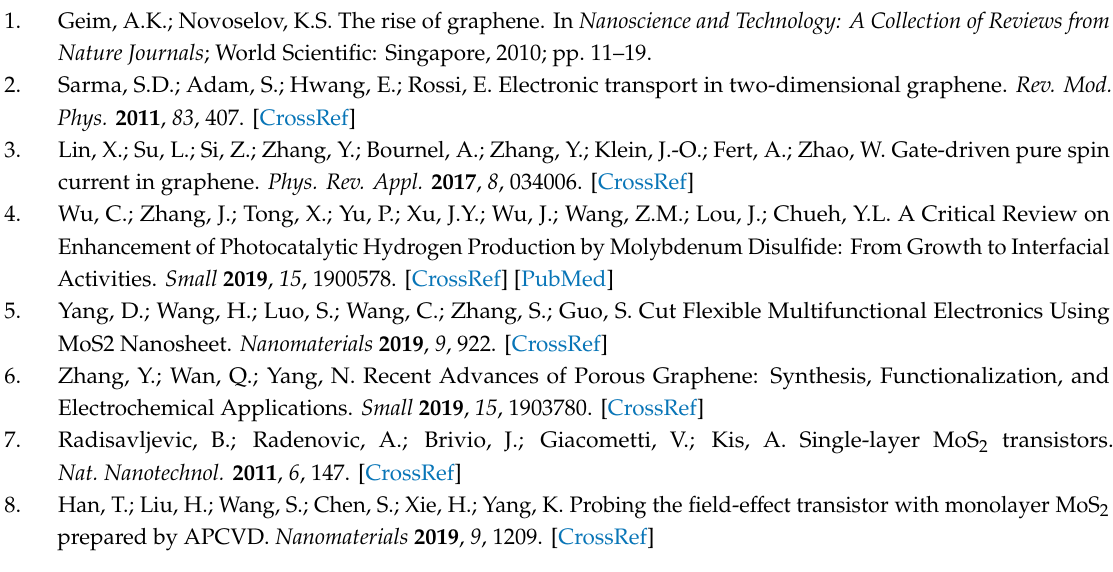
single layer in DNN and 1D-CNN. The result of misclassification of impurity classification; Figure S8: OM image and prediction results of the new pending data at 40 × magnification; Figure S9: At 100 × magnification, (a) and (e) are the OM images of the training (train data) and new test (new pending data) sets. (b) DNN, (c) 1D-CNN, and (d) 3D-CNN indicate the prediction results of the color classification image (false-color composite) in the training data. (f) DNN, (g) 1D-CNN, and (h) 3D-CNN reflect the prediction results of the color classification image (false-color composite) in the new pending data, from DNN and 1D-CNN in the single layer with the wrong double-layer classification misjudgment results; Figure S10: OM image and prediction results of the new pending data at 100 × magnification; Figure S11: At 40 × magnification, the accuracy (Accuracy) and loss (Loss) of the convergence process in (a) DNN, (b) 1D-CNN, and (c) 3D-CNN; validation set in (d) DNN, (e) 1D-CNN, and (f) 3D-CNN confusion matrix results; Figure S12: At 100 × magnification, the accuracy (Accuracy) and loss (Loss) of the convergence process in (a) DNN, (b) 1D-CNN, and (c) 3D-CNN; validation set in (d) DNN, (e) 1D-CNN, and (f) 3D-CNN confusion matrix results; Figure S13: Optical microscope light intensity distribution analysis. (a,d,g) OM images of sapphire substrate taken at 10 × , 40 × , and 100 × magnification rates (50, 15, and 10 µ m in the lower right corner, respectively). (b,e,h) V channels in the HSV color space of the microscope image (lightness) light intensity distribution. (c,f,i) Scatter plots of each pixel point RGB channel in the OM image; Figure S14: Prediction rate of each classification type at the shooting magnification rates of (a) 10 × , (b) 40 × , and (c) 100 × ; Figure S15: Raman measurement of the hyperspectral image of the new test data (new data). (a) OM image at 100 × magnification, (b) prediction result compared with OM image at 100 × magnification, (c) Raman spectrum at three specific points in (d), and (d) Raman measurement result corresponding to (b). The number of layers in the ROI circle is consistent, the triangle is a single-layer structure, and the intermediate core point is a double layer; Figure S16: SEM measurement of the hyperspectral image of the new test data (new data). (a,b) are OM images at 100 × and 40 × magnification rates, (c,d) are prediction results corresponding to the (a,b) OM image ranges, and (e,f) correspond to (c,d) ROI measurement results; Figure S17: (a) Photoluminescence spectrometry. (b) OM image of selected PL mapping range. (c) PL mapping with a wavelength of 625 nm (d) PL mapping with a wavelength of 667 nm. (e) The blue measurement in (d) indicates the PL measurement result of the test piece; Figure S18: (a) is the OM image after growing MoS 2 , (b) is the cross-sectional TEM image of the selected area of (a), (c) is the magnified TEM image of the red arrow of (b). (d) is the HRTEM image at the red box in (c). (e) is the HRTEM image at the orange box in (c), and (f) is the HRTEM image at the yellow box in (c). (g) is the SAED diagram of (d), (h) is the SAED diagram of (e), and (i) is the SAED diagram of